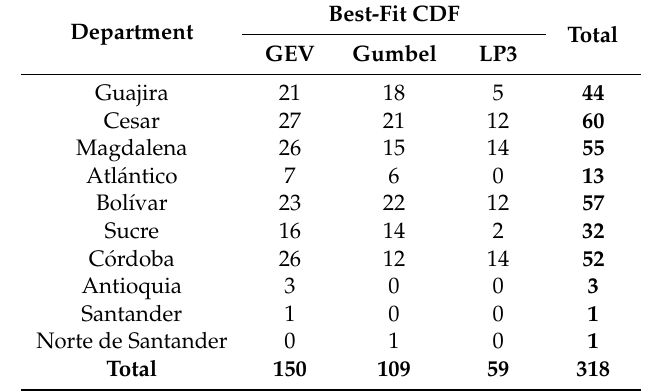
Table 4. Best CDFs per department. GEV, Generalized Extreme Value; LP3, Log-Pearson 3.